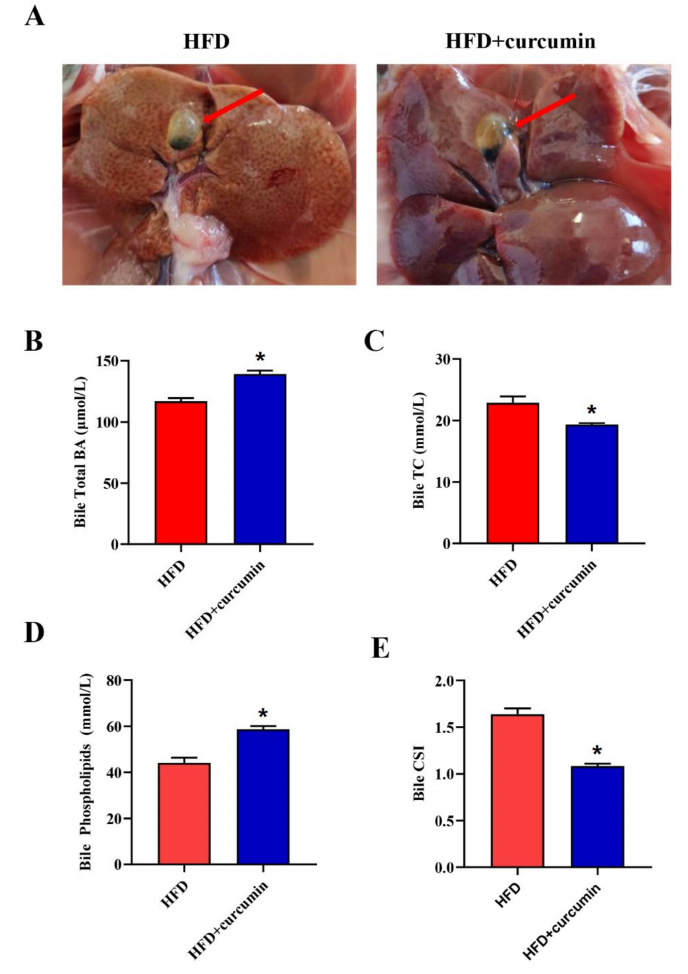
Figure 2. Effects of curcumin on bile compositions in gallbladder of HFD-fed hamsters. ( A ) Typical pictures of gallbladders; ( B – E ) The bile total BAs, TC, phospholipids levels and CSI in two groups. The red arrows refer to gallbladders. Data are expressed as mean ± SEM ( n = 8), * p < 0.05 compared to HFD group. BAs, Bile acids; TC, Total cholesterol; CSI, Cholesterol saturation